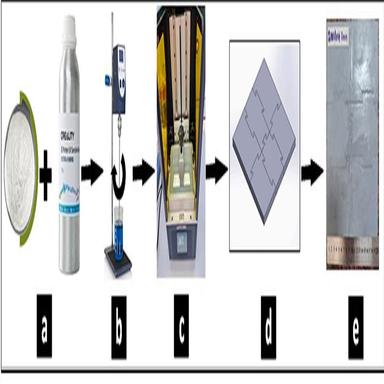
Production workflow chart of the study; Resin and MEPCM (a), Mixing of Resin and MEPCM (b), used printer apparatus (c), technical view of parts printed (d) and printed and assembled parts (e).